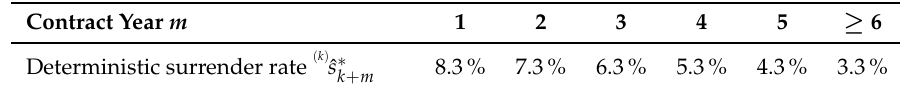
Table 4. Deterministic lapse rates.